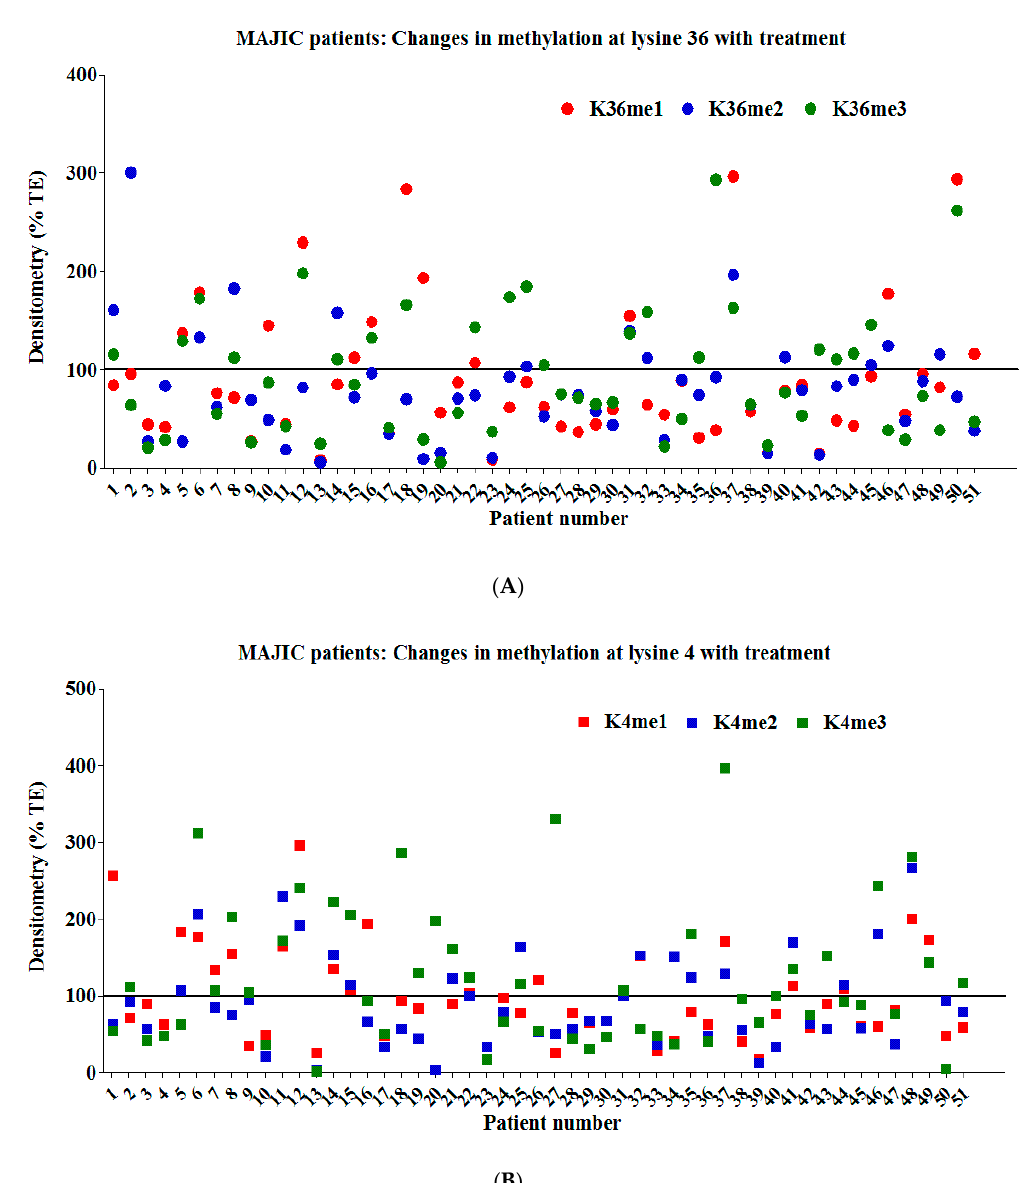
Figure 4. ( A ) MAJIC patients, modification of marks at lysine 36 in follow-up samples. For all 51 patients examined, the percentage change in each form of methylation at lysine 36 on histone H3. ( B ) MAJIC patients, modification of marks at lysine 4 in follow-up samples. For all 51 patients examined, the percentage change in each form of methylation at lysine 4 on histone